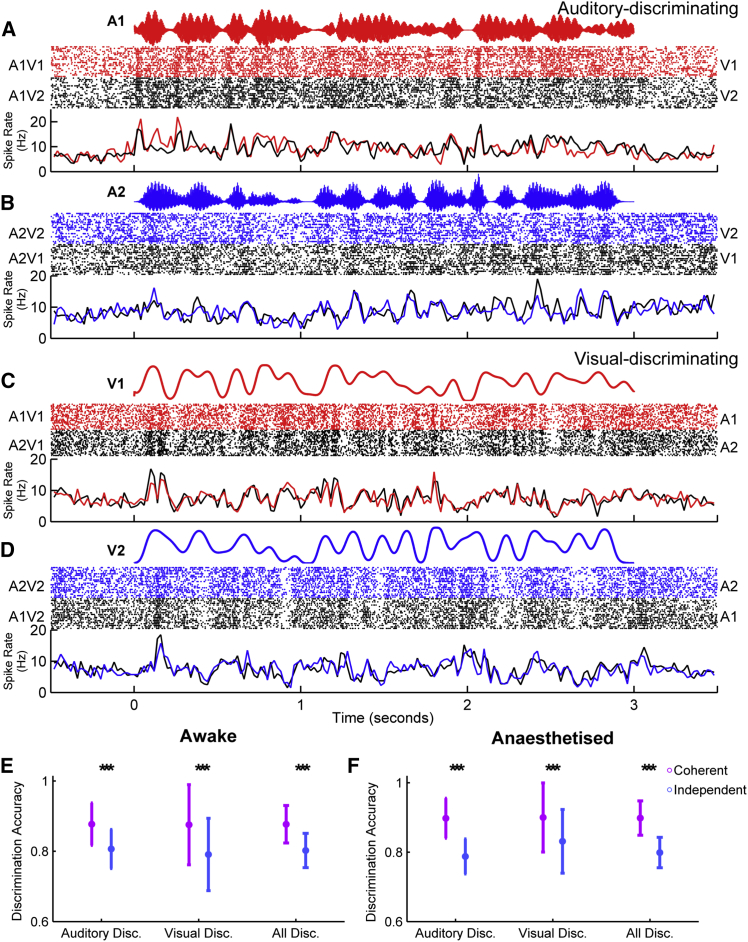
Auditory-Visual Temporal Coherence Enhances Neural Coding in Auditory Cortex(A–D) A pattern classifier was used to determine whether neuronal responses were informative about auditory or visual stimuli. The responses to single-stream stimuli are shown for two example units, with responses grouped according to the identity of the auditory (A and B, for an auditory discriminating unit) or visual stream (C and D, for a visual discriminating unit). In each case, the stimulus amplitude (A and B)/luminance (C and D) waveform is shown in the top panel with the resulting raster plots and PSTHs below.(E and F) Decoder performance (mean ± SEM) for discriminating stimulus identity (coherent: A1V1 versus A2V2, purple; independent: A1V2 versus A2V1, blue) in auditory and visual classified units recorded in awake (E) and anesthetized (F) ferrets. Pairwise comparisons for decoding of coherent versus independent stimuli (∗∗∗p < 0.001).